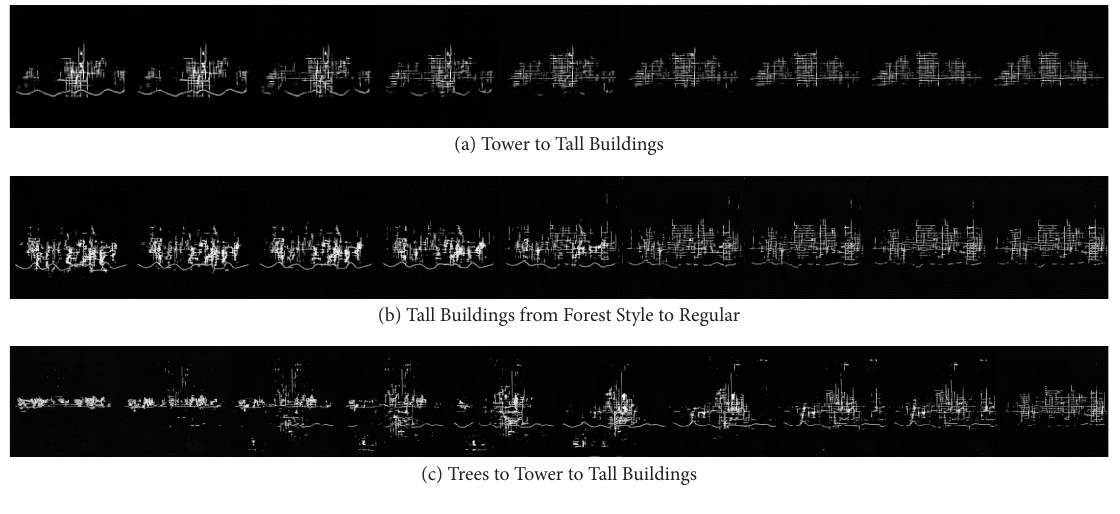
Figure 9. These are style transformations of multiple-style drawings training on a smaller truncated scale: ( a ) Style transfer from tower to tall buildings. ( b ) Style transfer from forest style tall buildings to normal tall buildings. ( c ) Style transfer from trees to tower to tall